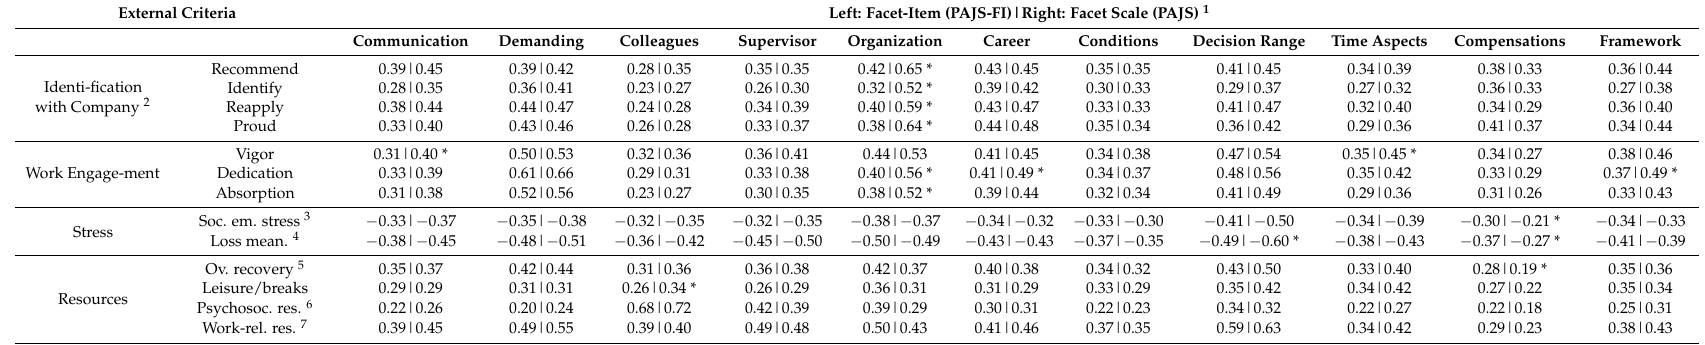
Table 5. Correlations between facet-items (Profile Analysis of Job Satisfaction Facet-Item, PAJS-FI; on the left) and facet scales (Profile Analysis of Job Satisfaction, PAJS; on the right) with the external criteria Identification with Company, Work Engagement, Stress, and Resources (N =